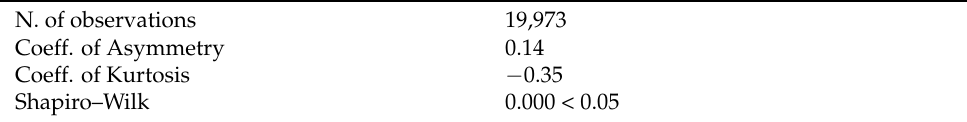
Table 4. Coefficient of asymmetry and kurtosis, normality tests for age, 2019. N. of